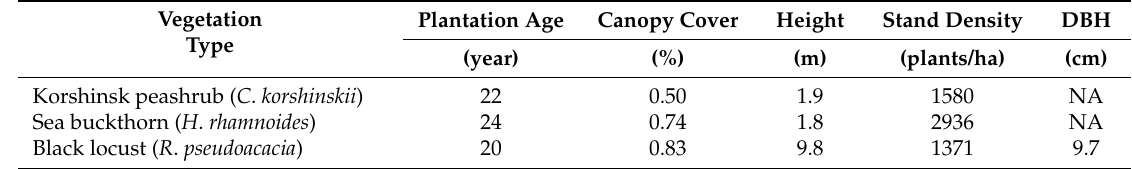
Table 1. Vegetation characteristics for each type of plantation.